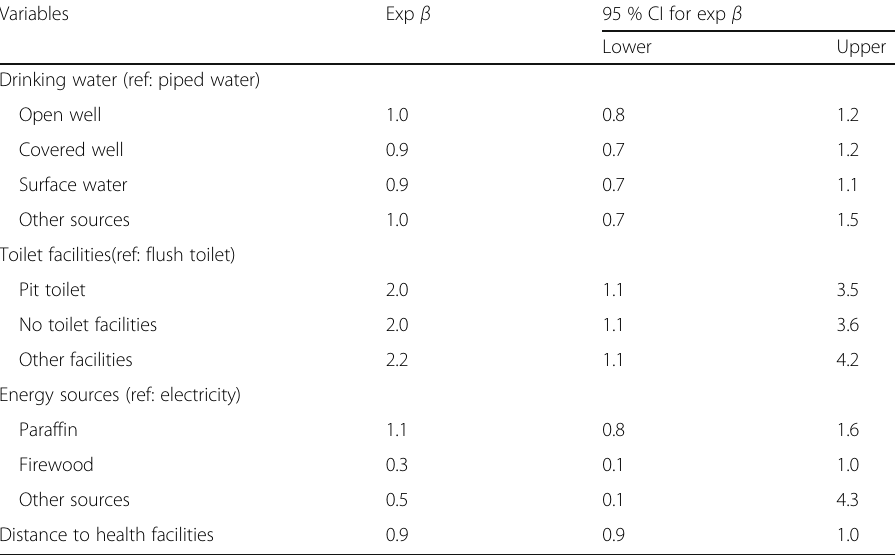
Exp β 95 % CI for exp